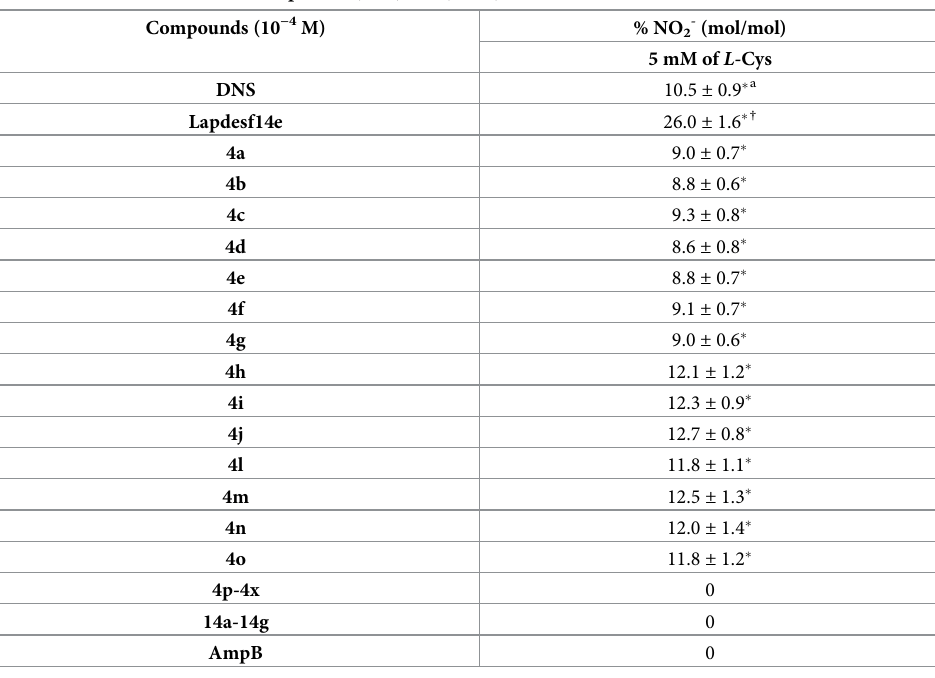
Table 1. NO-released data for compounds (4a-x) and